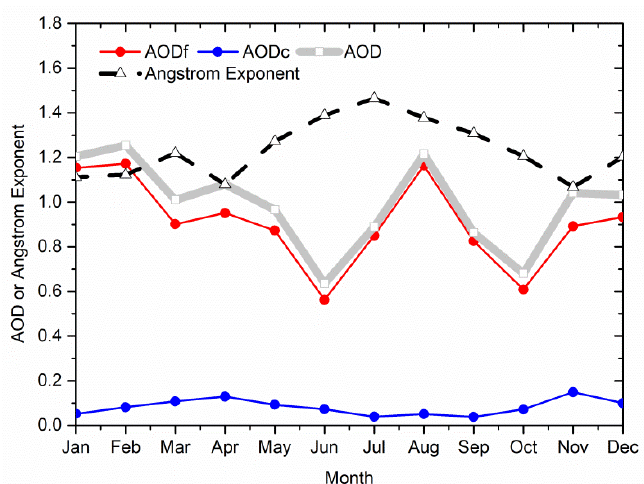
Figure 2. Monthly mean of aerosol optical depth (AOD), AOD f , AOD c at 440 nm and Angstrom Figure 2 ． Monthly mean of aerosol optical depth (AOD), AOD f , AOD c at 440nm and Angstrom Exponent (440–870 nm) in SONET Chengdu site from 2013 to Exponent (440–870 nm) in SONET Chengdu site from 2013 to 2016.